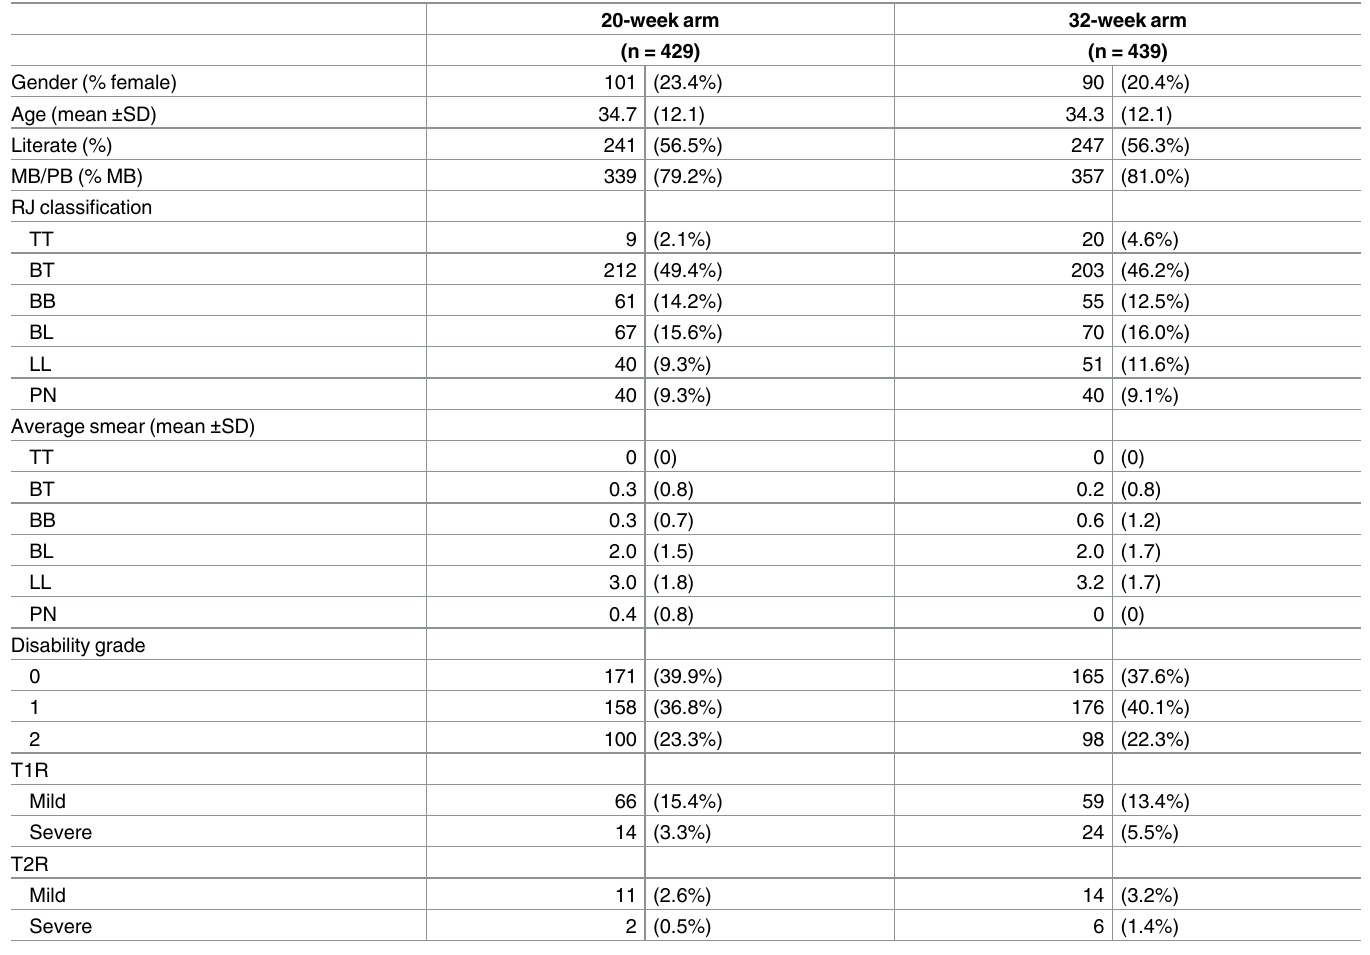
Table 3. Baseline demographics and clinical characteristics of the 868